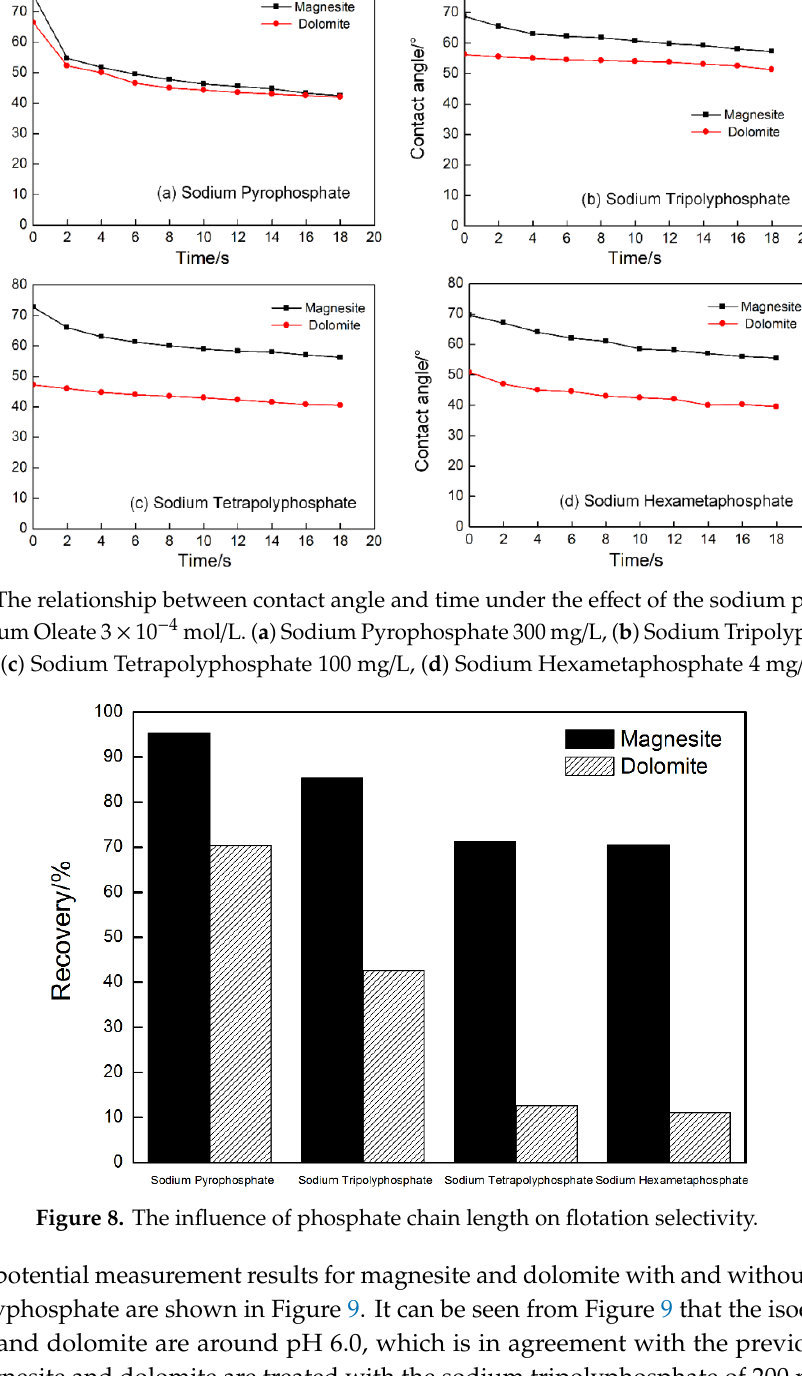
Figure 6. The effect of pH on mineral flotation recovery with different depressants. Sodium Oleate 3 × 10 –4 mol/L. ( a ) Sodium Pyrophosphate 300 mg/L, ( b ) Sodium Tripolyphosphate 200 mg/L, ( c )